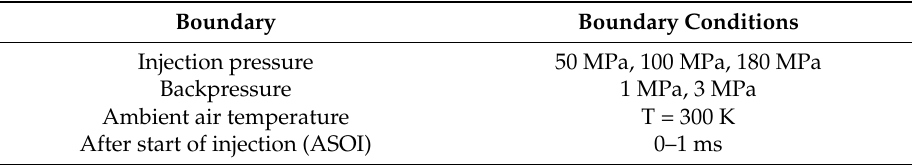
Table 4. Operating boundary